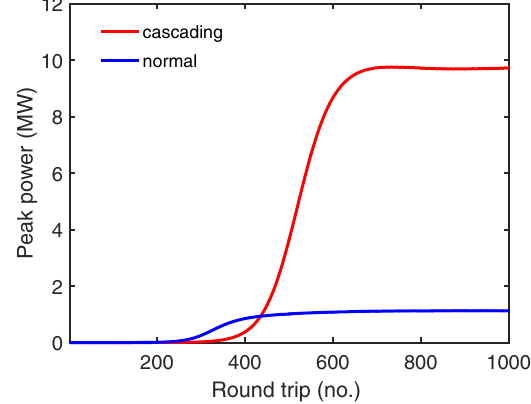
FIG. 7. The growth of output peak power in x-ray FEL oscillators from steady-state simulations, in which the total reflectivity and single-pass gain are assumed to be 89.8% and 15%, respectively, and the output coupling is